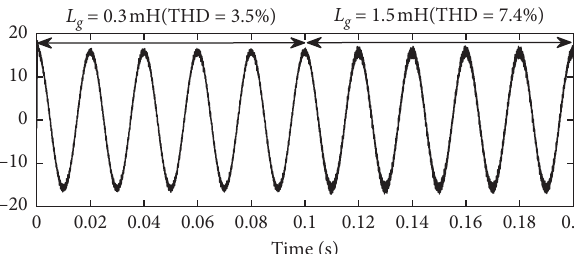
Figure 10: Currentwaveformwhenthegridresistancechangesat0.1s. Selected signal: 15 cycles. FFT window (in red): 4 cycles